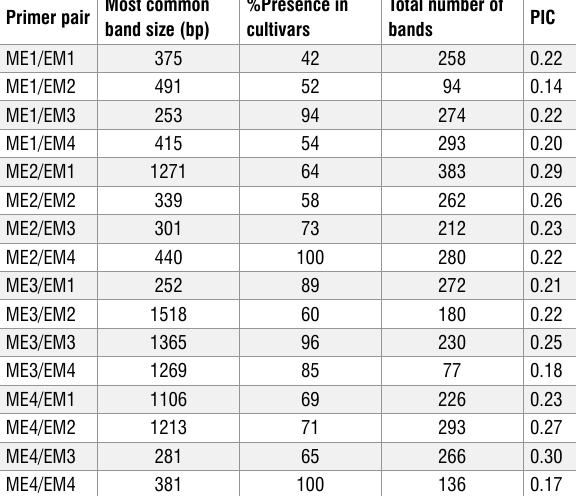
Summary of band characteristics per primer pair and polymorphism information content